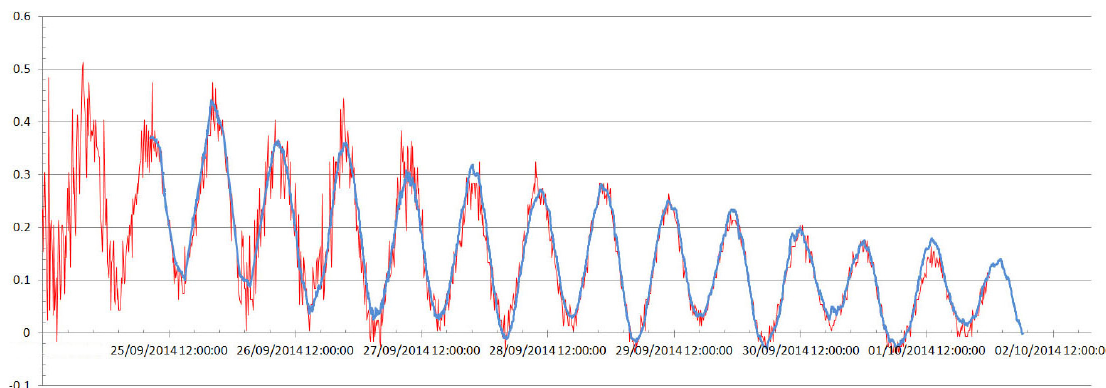
Figure 4. Leveling of tide gauge data collected by the local station installed during surveys at Pignataro harbor (in blue) with respect to av- eraged values from the Ginostra station (in red), located at Stromboli Island (data from the National Tide gauge Network, www.mareografico.it). Sampling rate is four